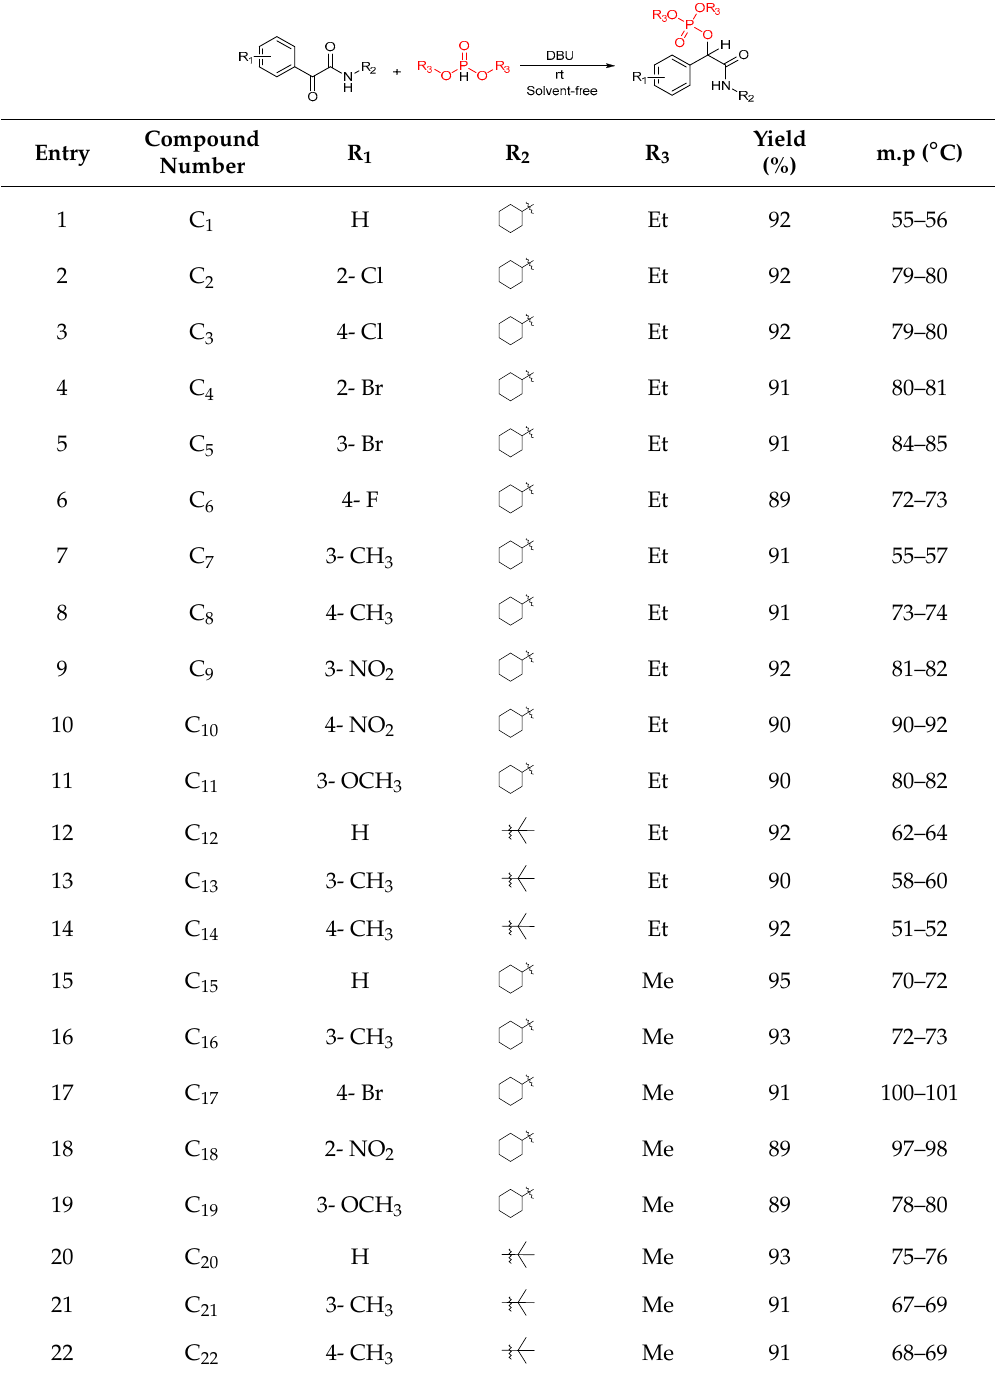
Table 2. The synthesis of a series of α -Phosphate Amide derivatives a . Table 2. The synthesis of a series of α‐ Phosphate Amide derivatives a . Table 2. The synthesis of a series of α‐ Phosphate Amide derivatives a . Table 2. The synthesis of a series of α‐ Phosphate Amide derivatives a . Table 2. The synthesis of a series of α‐ Phosphate Amide derivatives a . Table 2. The synthesis of a series of α‐ Phosphate Amide derivatives a . Table 2. The synthesis of a series of α‐ Phosphate Amide derivatives a . Table 2. The synthesis of a series of α‐ Phosphate Amide derivatives a . Table 2. The synthesis of a series of α‐ Phosphate Amide derivatives a . Table 2. The synthesis of a series of α‐ Phosphate Amide derivatives a . Table 2. The synthesis of a series of α‐ Phosphate Amide derivatives a . Table 2. The synthesis of a series of α‐ Phosphate Amide derivatives a . Table 2. The synthesis of a series of α‐ Phosphate Amide derivatives a . Table 2. The synthesis of a series of α‐ Phosphate Amide derivatives a . Table 2. The synthesis of a series of α‐ Phosphate Amide derivatives a . Table 2. The synthesis of a series of α‐ Phosphate Amide derivatives a . Table 2. The synthesis of a series of α‐ Phosphate Amide derivatives a . Table 2. The synthesis of a series of α‐ Phosphate Amide derivatives a . Table 2. The synthesis of a series of α‐ Phosphate Amide derivatives a